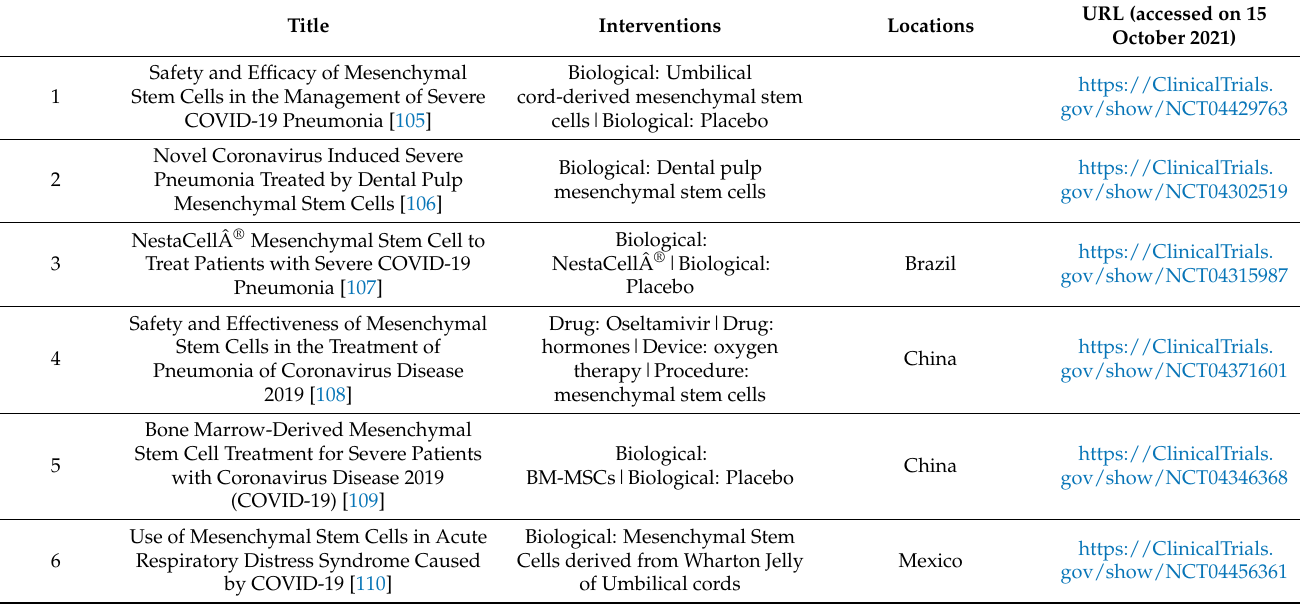
Table 2. List of active clinical trials studying the safety and efficacy of MSC therapy to treat COVID-19 induced conditions that have completed recruitment as of October